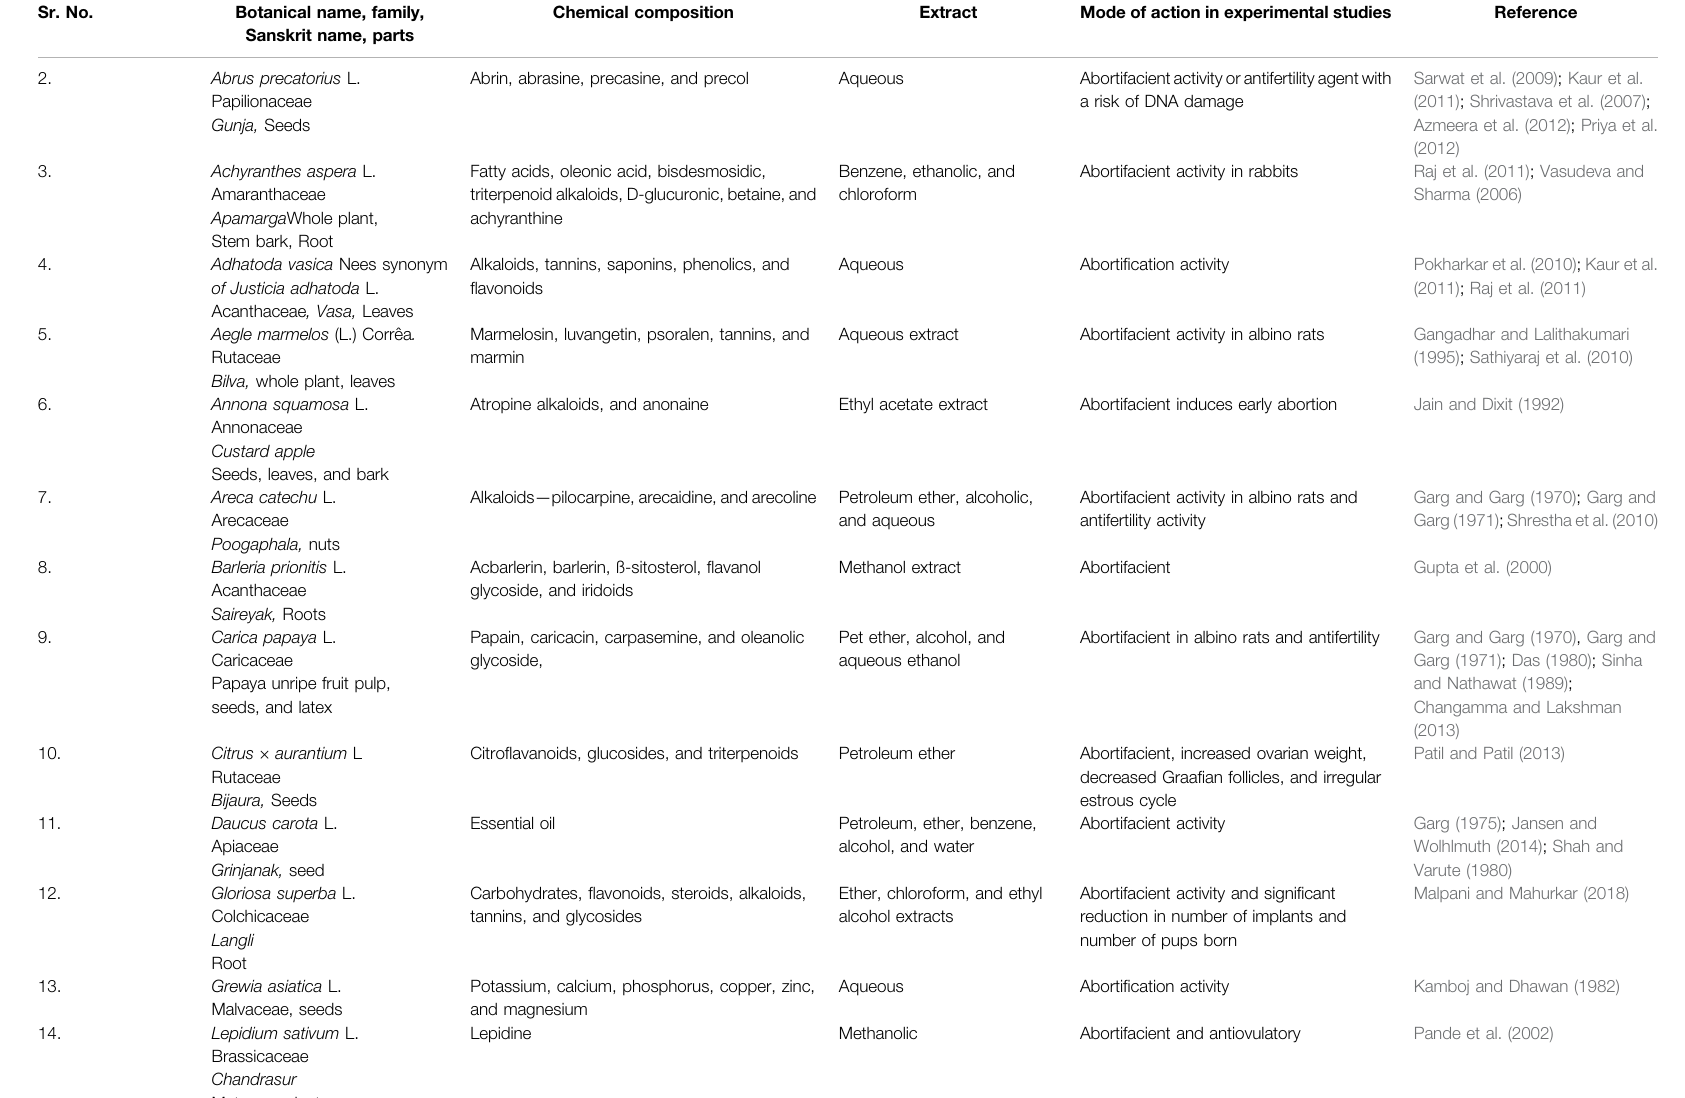
TABLE 2 | ( Continued ) Medicinal plants and their phyotoconstituents validated for various female/male contraceptive activities. Different contraceptive activities studied on medicinal plants could be categorized as follows. Female contraceptive activities: (2A) anti-implantation activity, (2B) aborti fi cation, (2C) antifertility, (2D) antiovulatory, and (2E) antiestrogenic activity. Male contraceptive activities: (2F) antispermatogenic, (2G) spermicidal, and (2H) antiandrogenic